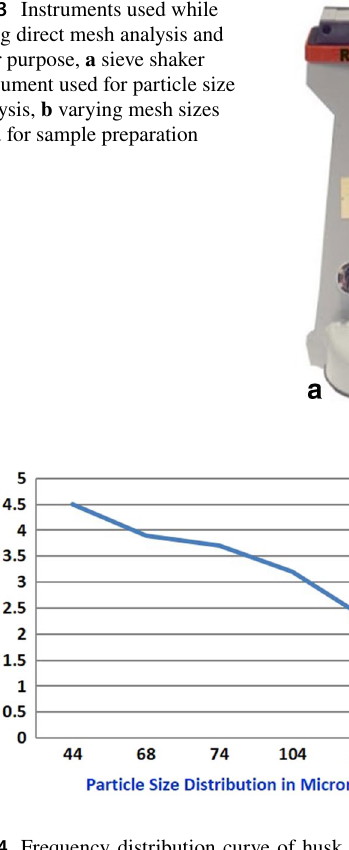
Fig. 4 Frequency distribution curve of husk fibers obtained by mesh